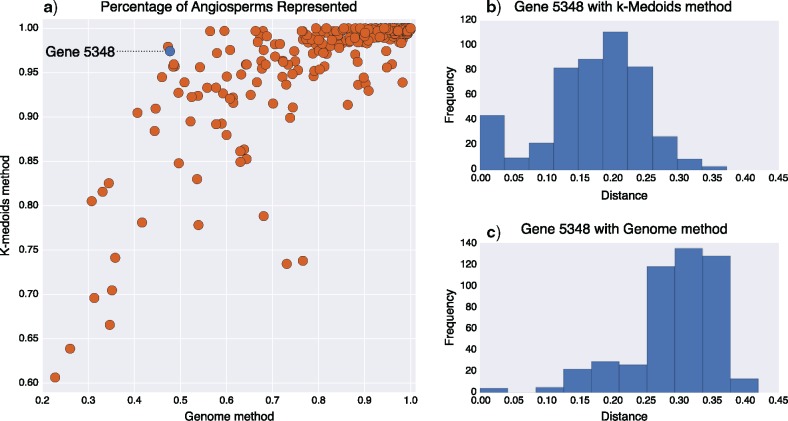
Comparison between the k-medoids method of selecting representative sequences with using the closest available angiosperm genome. a) Each point is one gene, and its position indicates the percentage of angiosperm transcripts (from OneKP) that fall within 30% sequence divergence of a representative sequence. Only genes where the k-medoids could represent 95% or more angiosperms were selected for probe design. Note the \documentclass[12pt]{minimal}
\usepackage{amsmath}
\usepackage{wasysym}
\usepackage{amsfonts}
\usepackage{amssymb}
\usepackage{amsbsy}
\usepackage{upgreek}
\usepackage{mathrsfs}
\setlength{\oddsidemargin}{-69pt}
\begin{document}
}{}$x$\end{document}-axis and \documentclass[12pt]{minimal}
\usepackage{amsmath}
\usepackage{wasysym}
\usepackage{amsfonts}
\usepackage{amssymb}
\usepackage{amsbsy}
\usepackage{upgreek}
\usepackage{mathrsfs}
\setlength{\oddsidemargin}{-69pt}
\begin{document}
}{}$y$\end{document}-axis ranges are not identical. Dotted dash line indicates gene 5348, which is highlighted in the other panels. b) Distribution of distances between each angiosperm sequence in 1KP and the nearest k-medoid for gene 5348. c) Distribution of distances between each angiosperm sequence in 1KP and the nearest published genome sequence for gene 5348.